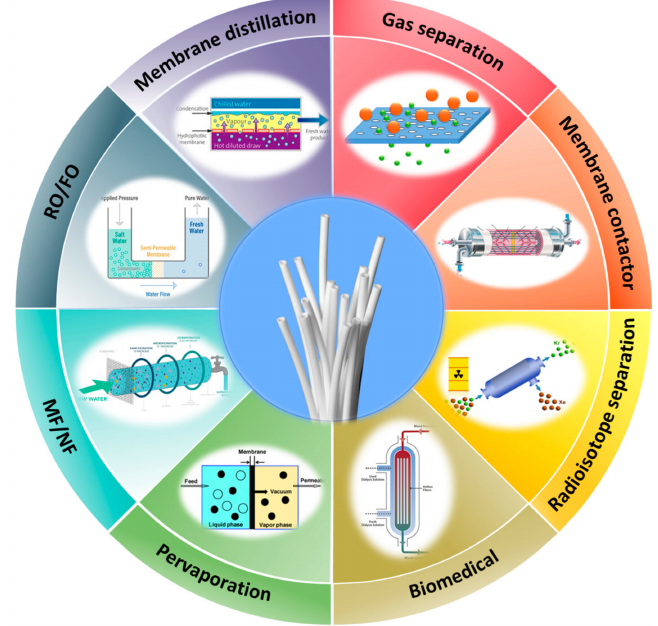
Figure 3. The applications of hollow fiber